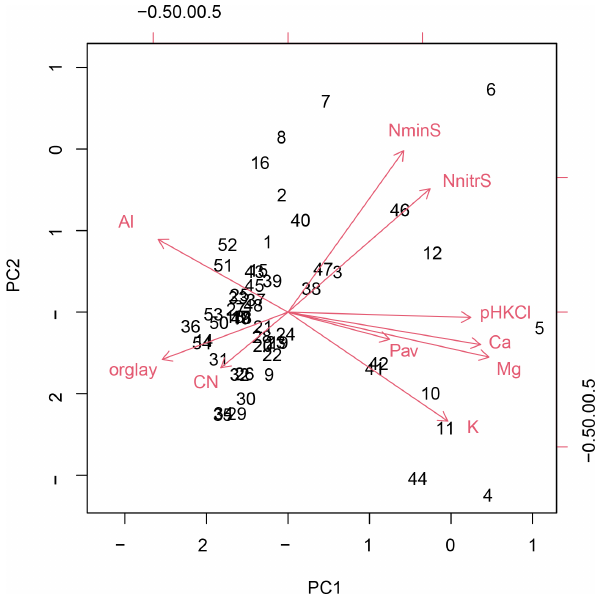
Figure B2. Principal component analysis of the soil properties of 54 study plots of the Loja transect; PC1 and PC2 explained 46.9% and 14.6% of variance, respectively.